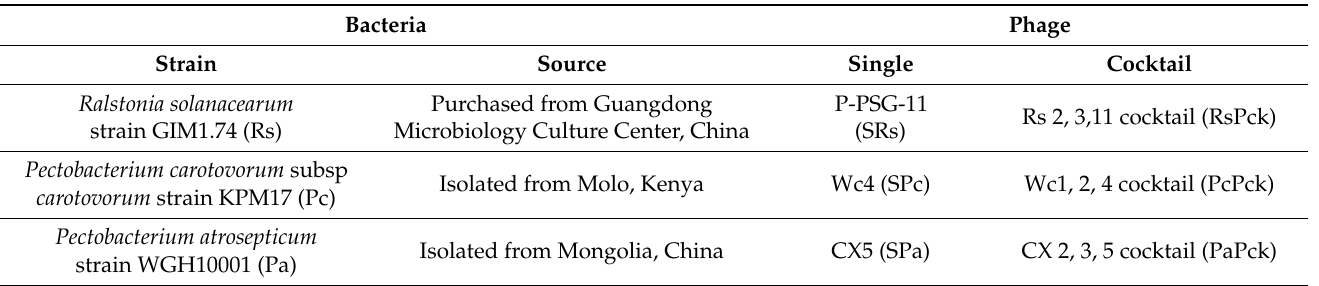
Table 1. Bacterial isolates and sources and well as phages are shown.